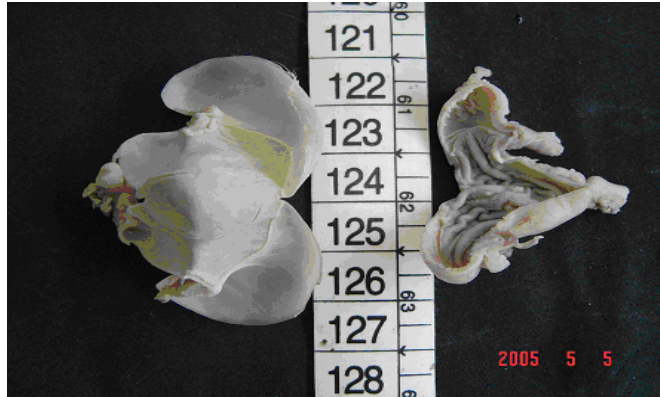
FIGURE 4 – Examples of the group G I at right and group G II at left, revealing the extinction of the linear depressions of the gastric